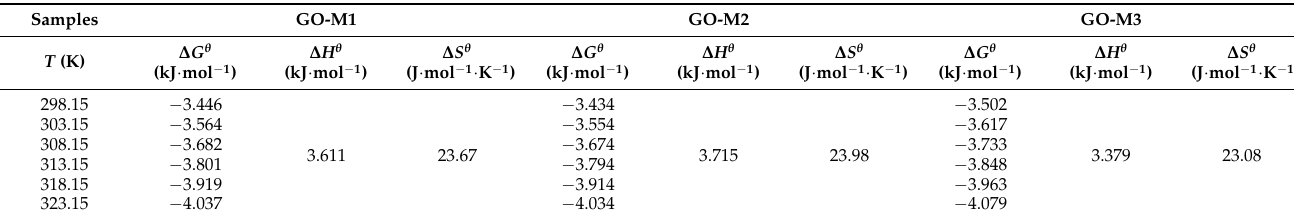
Table 7. Calculation parameters of thermodynamics for the adsorption of Cr(VI) on GOs. Samples